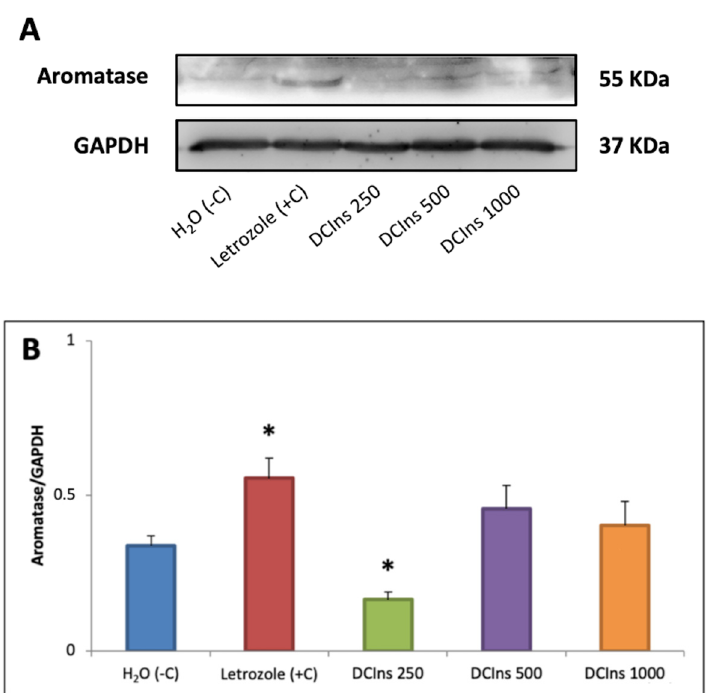
Figure 7. Levels of aromatase in the ovaries of mice at the end of the 21-day treatment. ( A ) Representative Western blot of aromatase in protein extracts from the ovaries of mice under the experimental conditions indicated. ( B ) Densitometric analysis of aromatase/GAPDH. Values represent the mean value ± SD of extracts from three independent experiments. *, difference vs. negative control mice, p < 0.05.